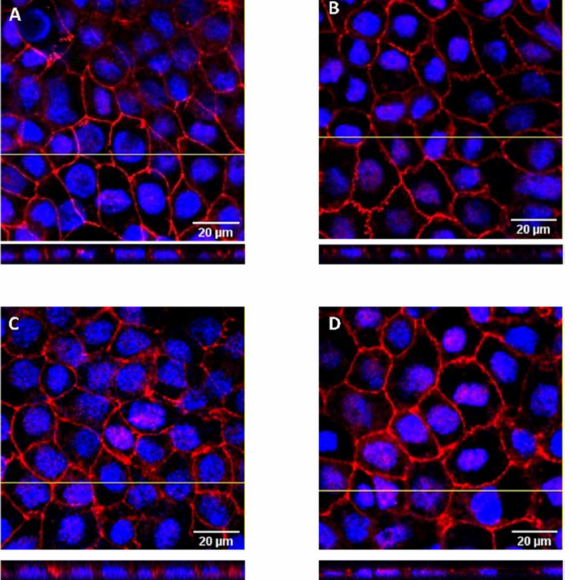
Figure 3. Confocal fluorescence images of Caco-2 monolayers stained for nuclei (blue) and ZO-1 (red). Representative optical section images along the z -axis (1 µ m) are shown for cell monolayers after exposure during the permeability assay with: ( A ) GCA 10 mM, ( B ) DHE 50 µ M + GCA 10 mM, ( C ) Coffee D1 + GCA 10 mM and ( D ) DHE 50 µ M + coffee D1 + GCA 10 mM. The lower insets show the localization of the ZO-1 fluorescence in the orthogonal view of the z-x plane marked with a yellow